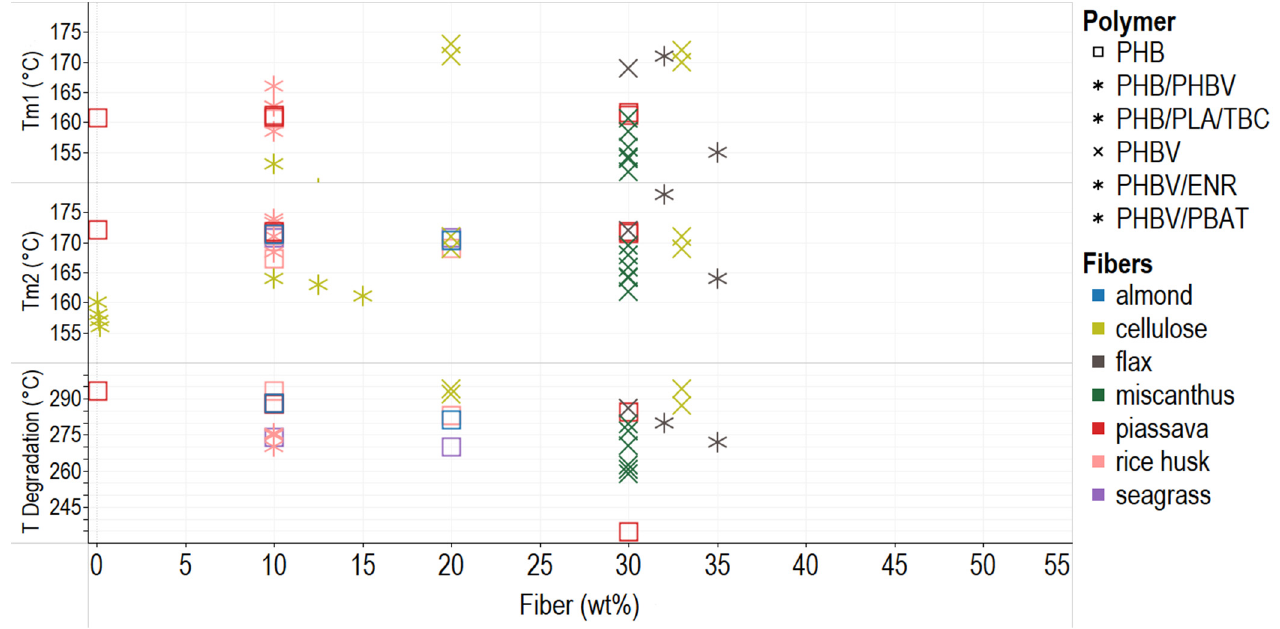
Figure 4. Thermal behavior of PHA–fiber composites. The colors refer to the fiber type (fillers), and the shapes refer to polymer types (matrix). Tm = temperature of melting.